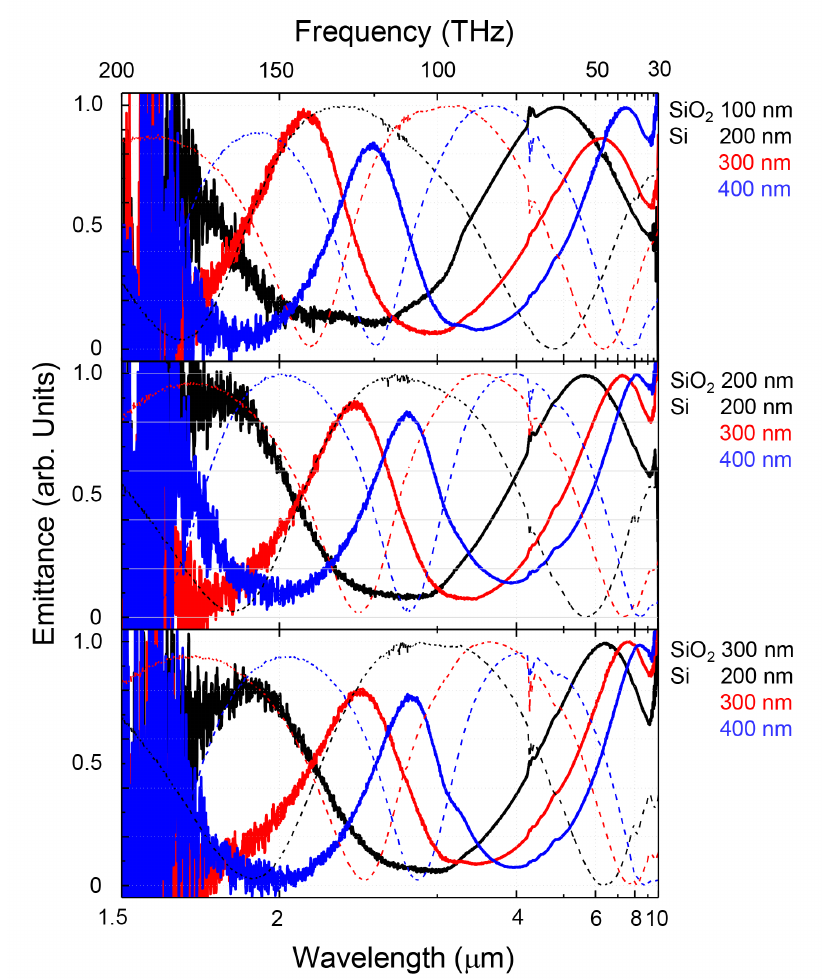
Figure 4. Experimental thermal radiation emission spectra of black metals; dashed lines are the reflectance spectra from Figure 3a. Thermodynamic equivalence based on energy conservation for absorbance, reflectance, and transmittance A + R + T = 1 requires that emittance E = 1 − R = A in the absence of transmittance, as is the case considered here due to a thick Au back reflector layer; Figure